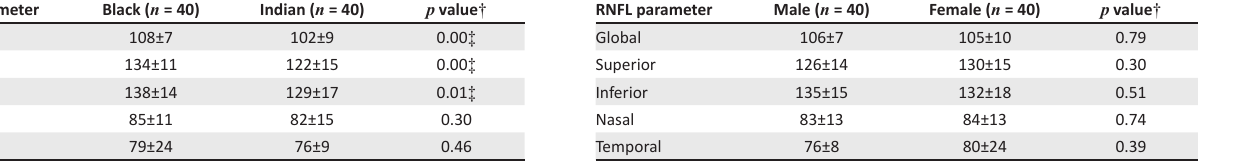
TABLE 2: Retinal nerve fibre layer thickness ( µ m) variations in black and Indian ethnic groups indicated with means and standard deviations. RNFL parameter